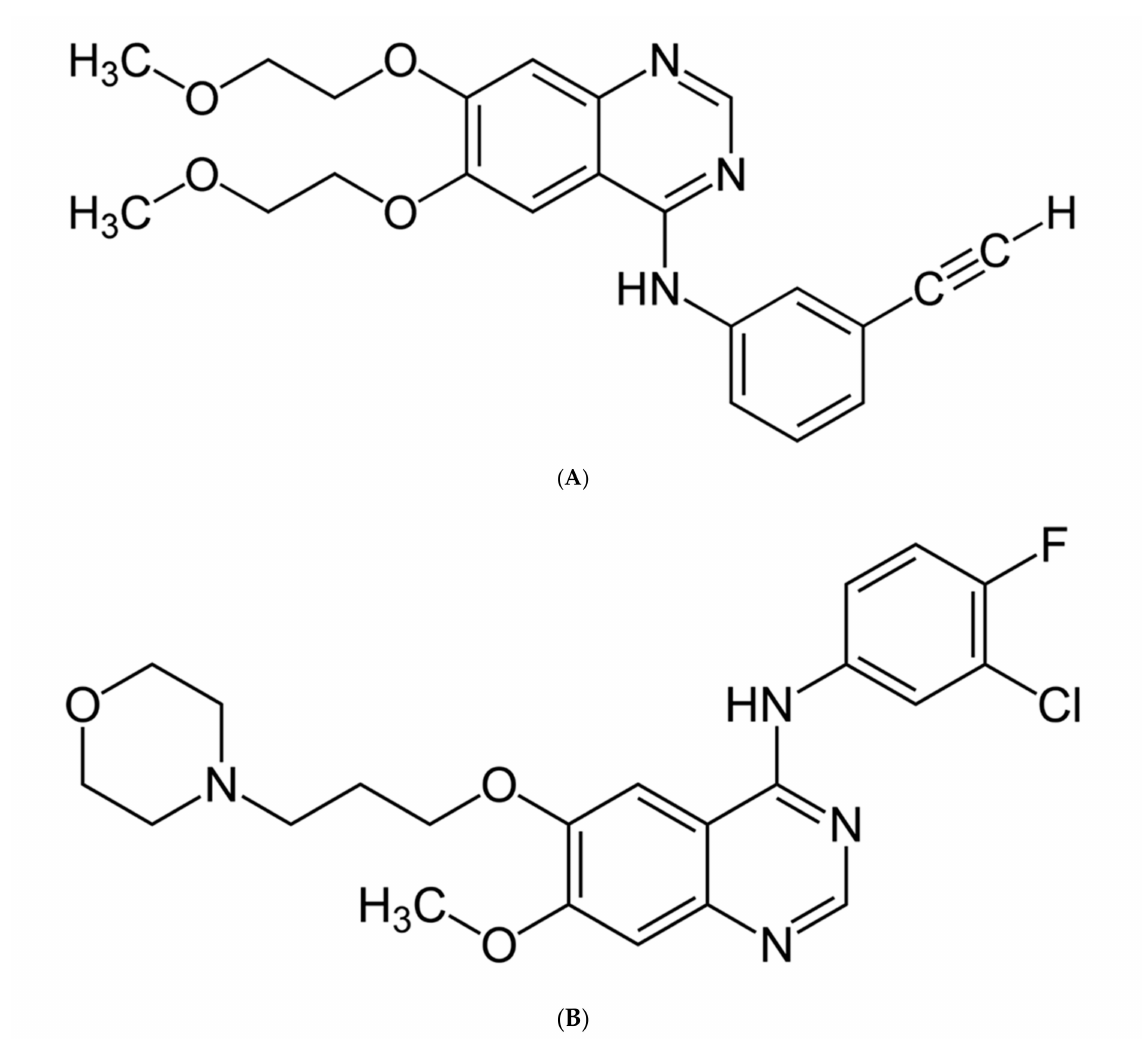
Figure 2. ( A ) Gefitinib—first-generation tyrosine kinase inhibitor; ( B ) Erlotinib—first-generation tyrosine kinase inhibitor. In Figure 3A, the inhibitor (dark blue), representing gefitinib, occupies the ATP cleft. The locations of the two missense mutations are shown within the activating loop of